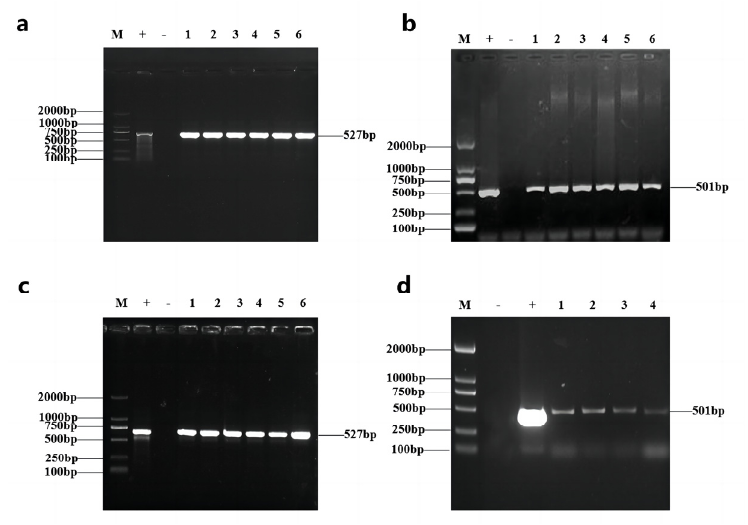
Figure 3. Identification of tobacco and soybean strains transgenic GmAP3 gene. ( a ) PCR detection of some T 1 overexpression transgenic tobacco, 1~6: sample; ( b ) PCR detection of some T 1 editing transgenic tobacco, 1~6: sample; ( c ) PCR detection of some T 1 overexpression transgenic soybean,